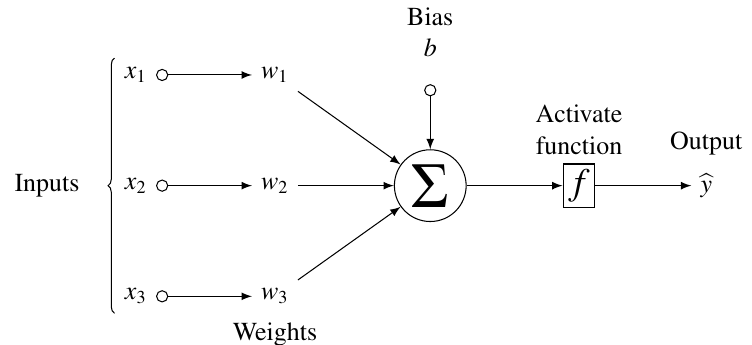
Figure 1: Schematic representation of an artificial neuron. Figure 1. Schematic representation of an artificial